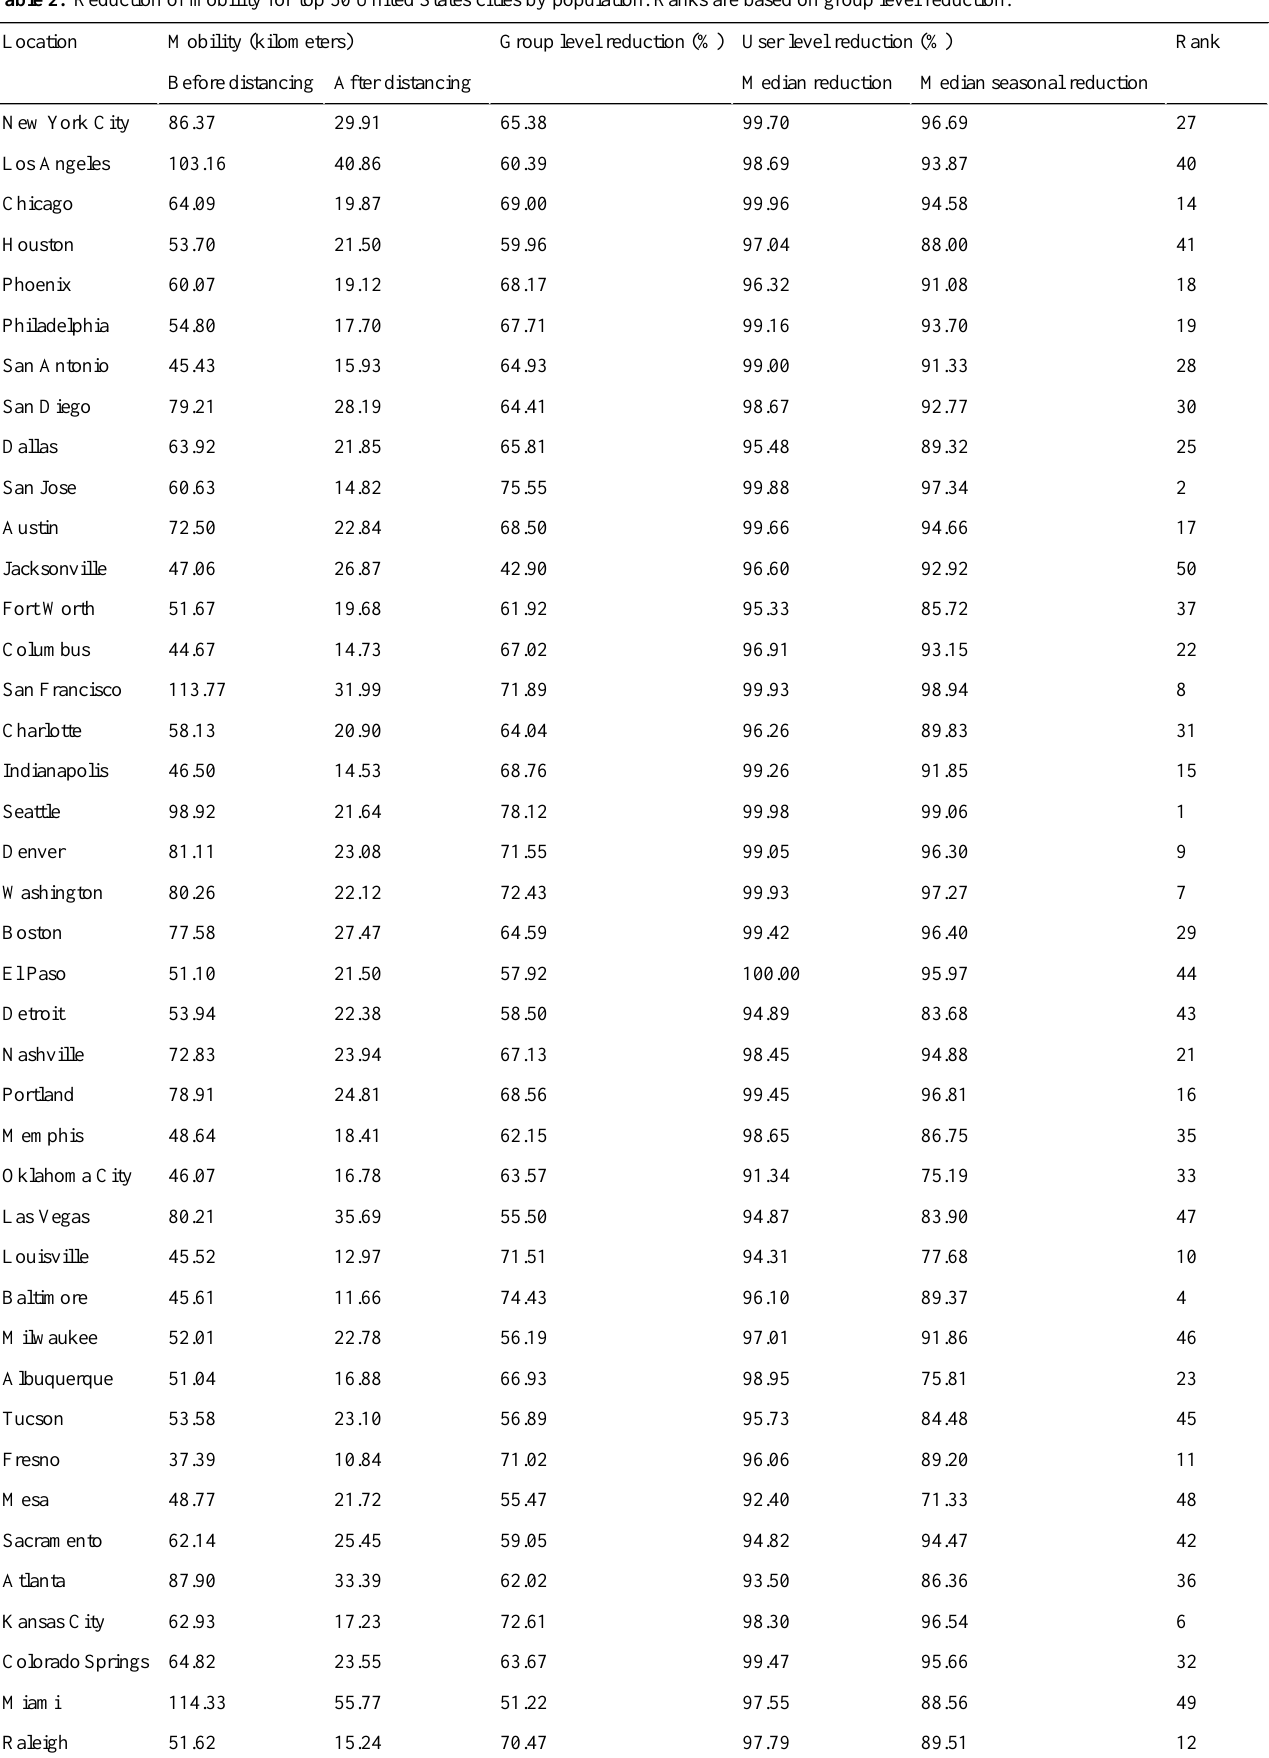
Table 2. Reduction of mobility for top 50 United States cities by population. Ranks are based on group level